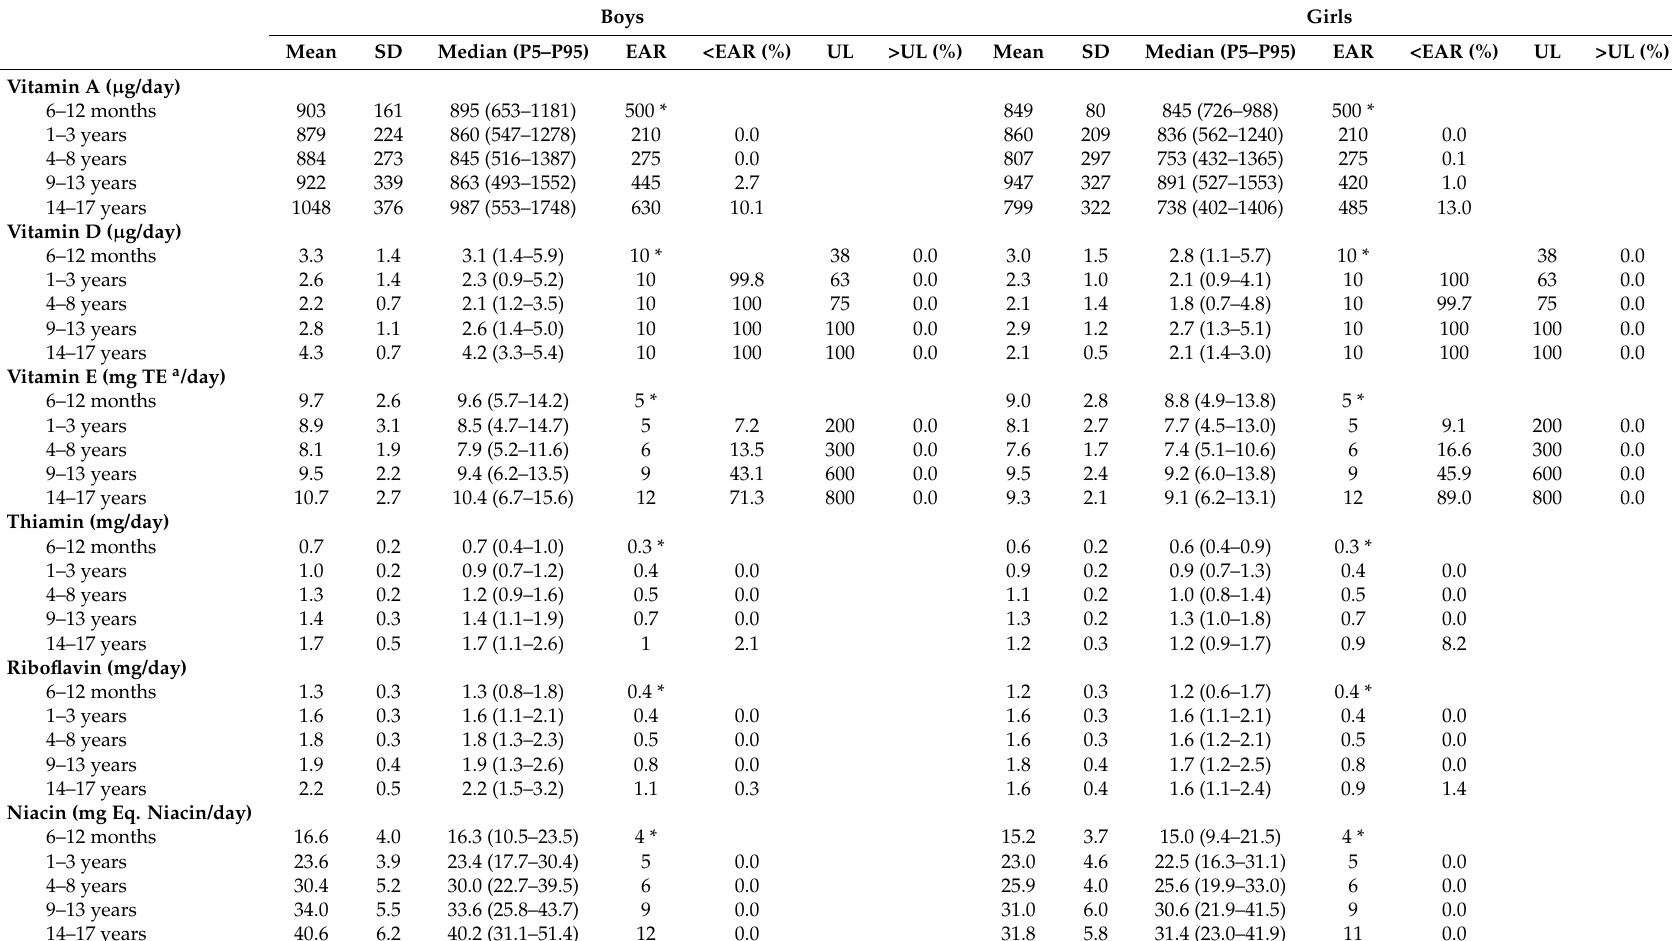
Table 2. Usual intakes (from food and beverage sources only) of vitamins in Spanish children and adolescents and inadequate